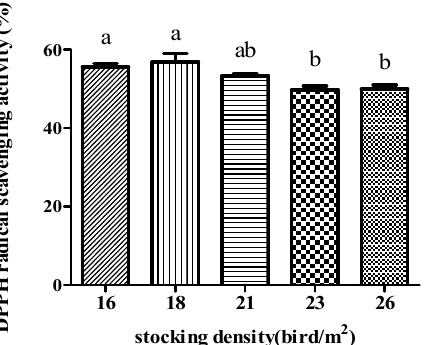
Figure 3. Effect of stocking density on 2,2-diphenyl-1-picrylhydrazyl (DPPH) radical scavenging activity in the breast meat of broiler chickens under high temperatures ( n = 15). Linear, p = 0.001; quadratic, p = 0.616. Bars with different letters (a,b) differ significantly across all groups ( p < 0.05). Table 4. Effect of stocking density on thiobarbituric acid (TBARS) in breast meat of broiler chickens The TBARS content of breast meat during storage is shown in Table 4. The under high temperatures during cold storage.